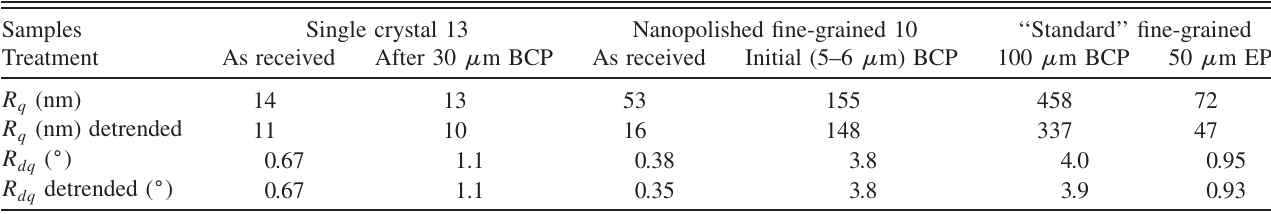
TABLE I. Averaged R q and R dq parameters with and without third order polynomial detrending with AFM scan range 100 (cid:1) m by 100 (cid:1) m (unit: